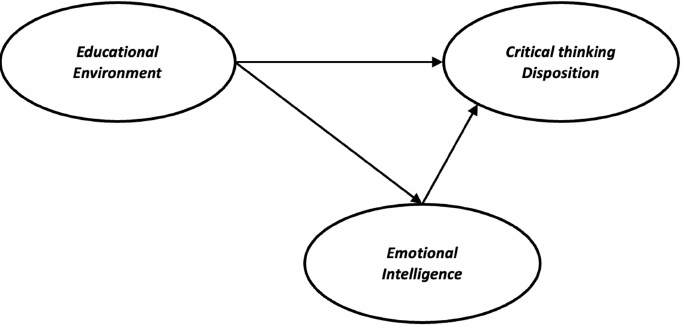
Figure 1. The hypothesized model of the